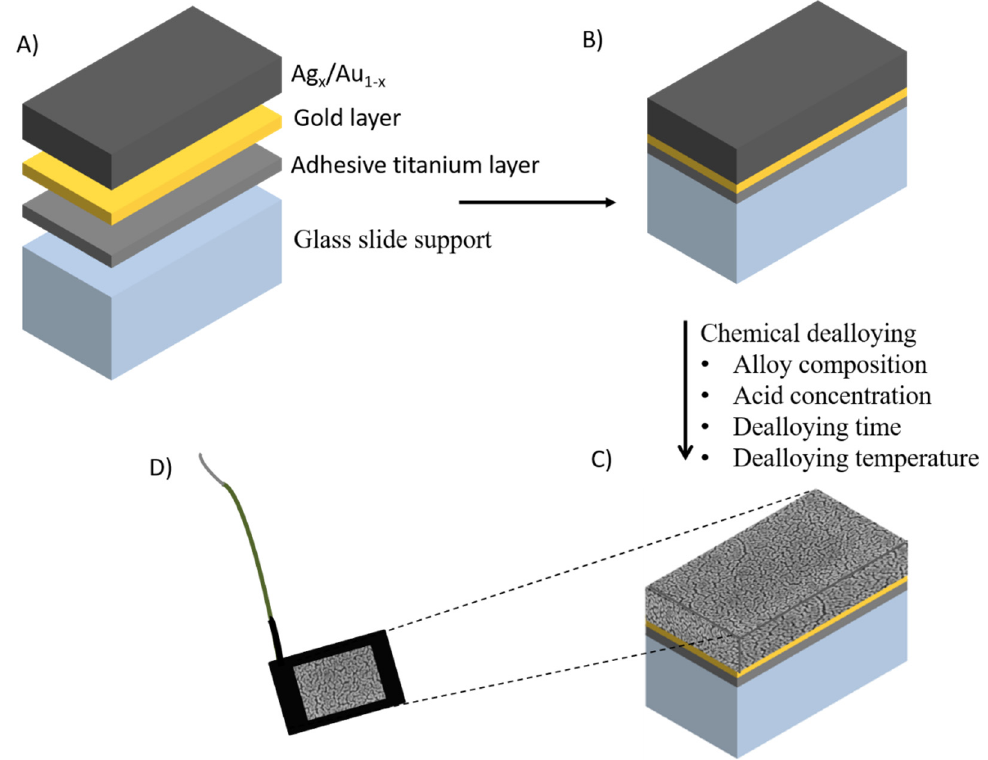
Figure 1. Schematic representation of the manufacture of nanoporous gold (NPG) electrodes with ( A ) different layers and thicknesses, ( B ) sputtered glass sheet prior to etching, ( C ) formation of nanopores after etching, and ( D ) the completed NPG electrode. Adapted from [46] .